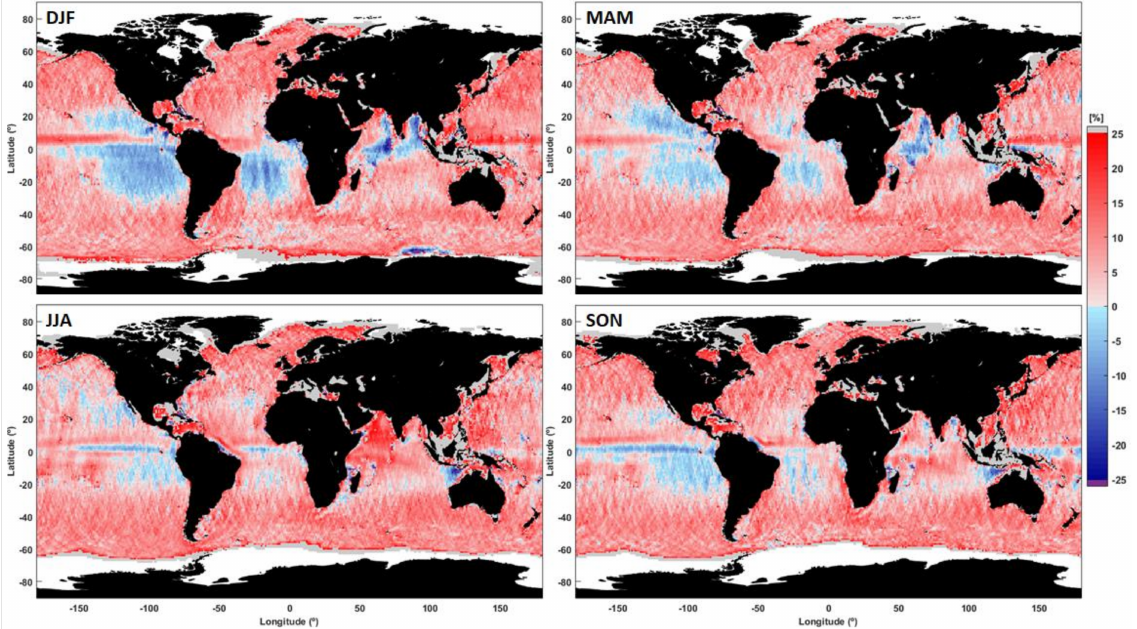
Figure 10. Normalized differences (%) between climatological means of E w-CCI and E w-ERA5 over the 27-year time in- terval (1992–2018); the seasons correspond to the Northern Hemisphere: winter (DJF), spring (MAM), summer (JJA), autumn